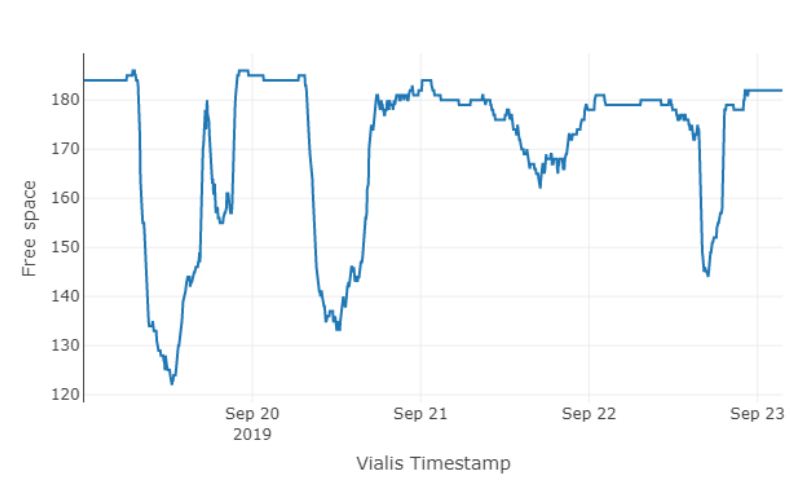
Figure 8. Hourly parking lot availability.